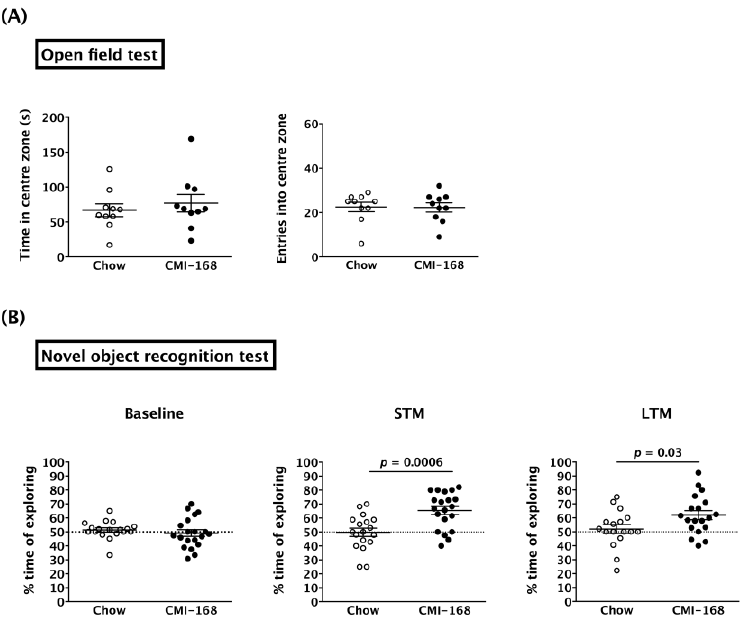
Figure 2. Effects of six-week CMI-168 dietary supplementation on the open field test (OFT) and novel object recognition test (ORT) in mice. ( A ) Time spent in the centre zone and the number of entries into the centre zone for the OFT. ( B ) Percentage of time spent exploring the chosen (in baseline) or novel objects (short-term memory (STM) and long-term memory (LTM)) in the ORT.